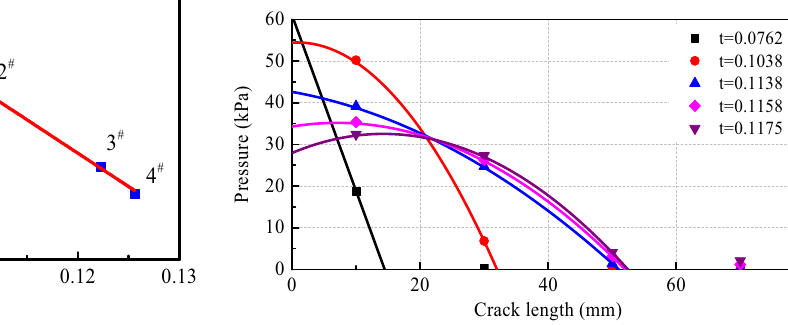
Figure 10: Typical water pressure distributions along the crack